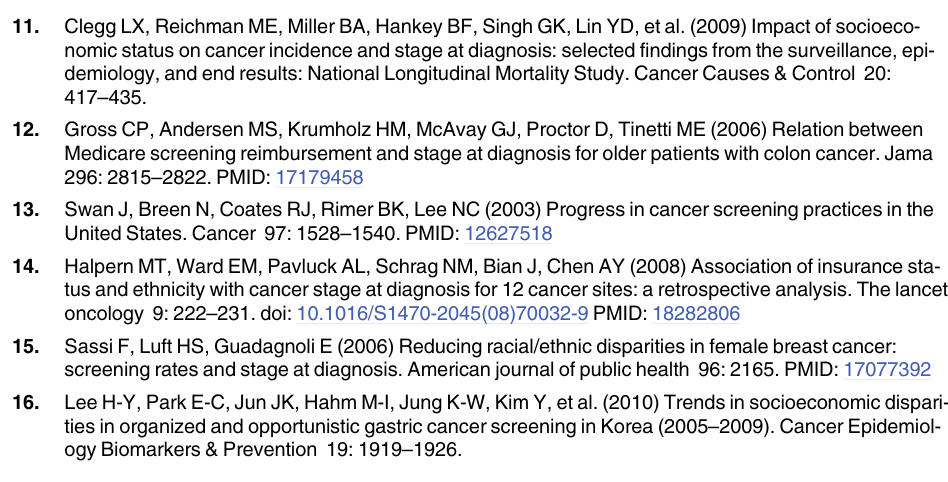
PLOS ONE | DOI:10.1371/journal.pone.0136036 August 18,